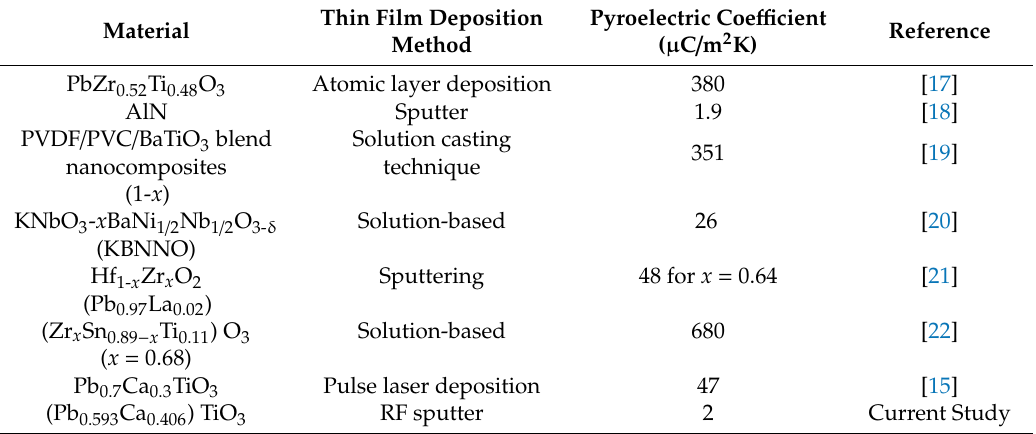
Table 4. Comparison of the pyroelectric coe ffi cients of various materials. RF: radio frequency. Thin Film Deposition Pyroelectric Coe ffi cient Material Reference Method ( µ C / m 2 K) PbZr 0.52 Ti 0.48 O 3 Atomic layer